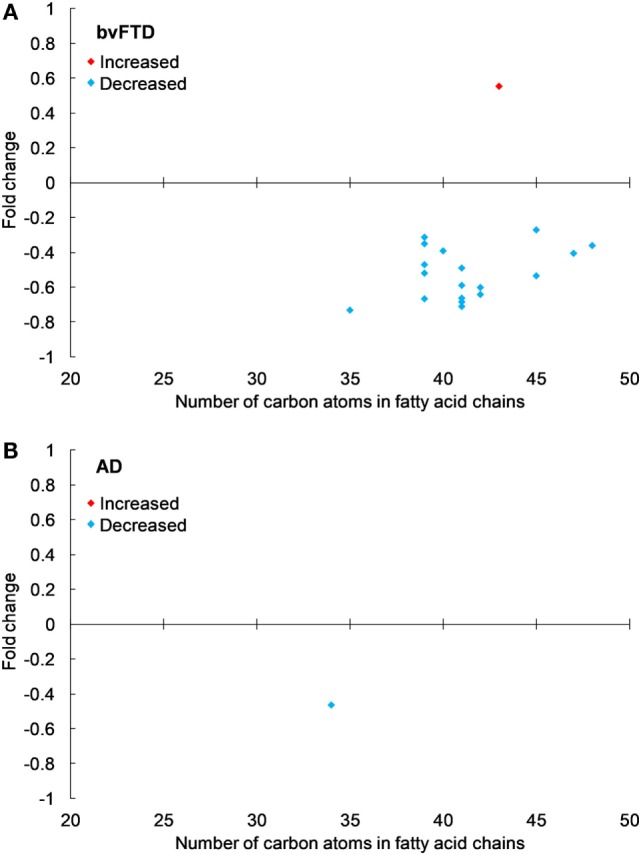
Phosphatidylserine species that were significantly altered in (A) behavioral variant frontotemporal dementia (bvFTD) and (B) Alzheimer’s disease (AD) compared to control. Each symbol represents a lipid species with different number of carbon atoms in fatty acid chains; red symbols are those that are significantly increased and blue symbols significantly decreased; p < 0.05. The data presented are fold changes on linear scale. Zero represents no change; 0.5 fold change represents 50% increase; and −0.5 represents 50% decrease.